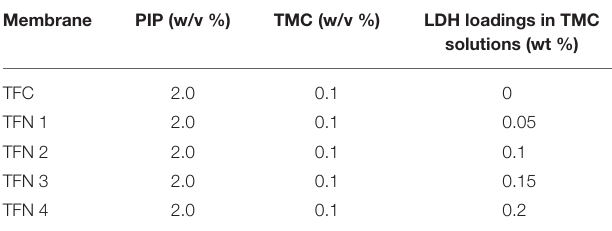
TABLE 1 | Composition of the amine solution in aqueous and acid chloride in organic phase and LDH loading.